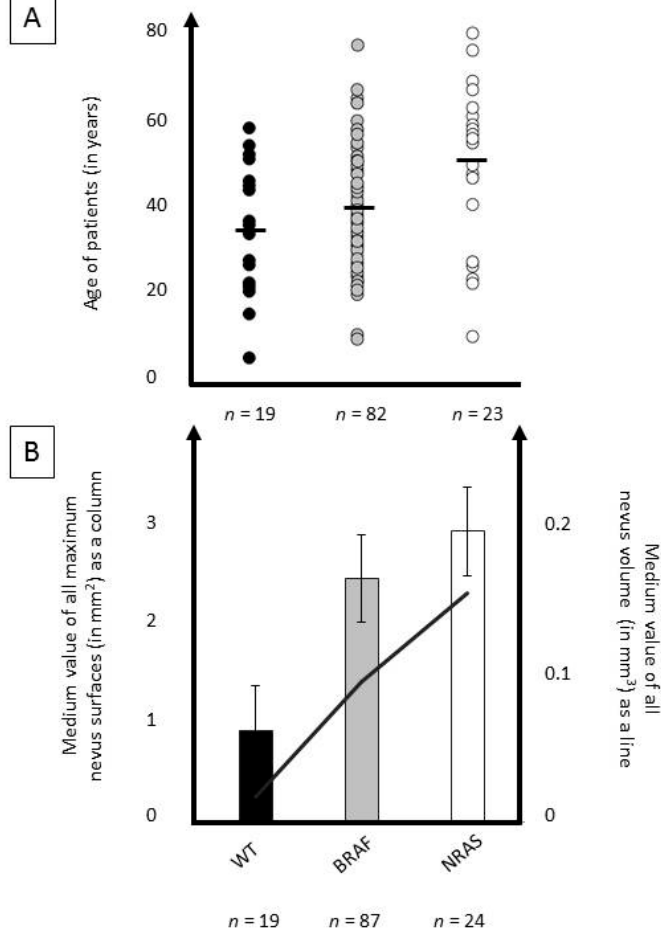
Figure 2. Associations of patients’ age, size, and volume of naevi with oncogene mutation status. ( A ) Distribution of patients according to their age in wild-type cohort (black), BRAF -mutant cohort (grey) and NRAS -mutant cohort (white) (mean age of cohort indicated by black line). ( B ) Medium size of naevus surface (in mm 2 ) depicted as columns for wild-type cohort (in black), BRAF -mutant cohort (in grey) and NRAS -mutant cohort (in white) with standard deviation. Medium volume of naevi for all three cohorts (WT, BRAF , NRAS ) is depicted as a black line.